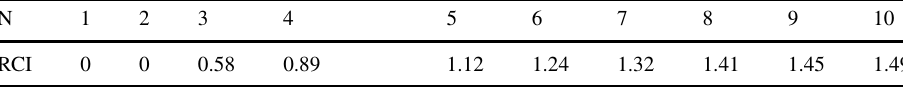
Table 5 Random index